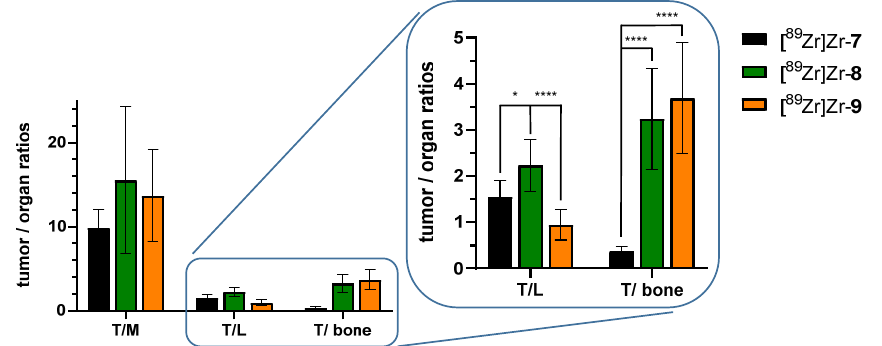
Figure 7. Tumor-to-organ ratios for the most relevant organs (tumor/muscle, tumor/liver and tu-